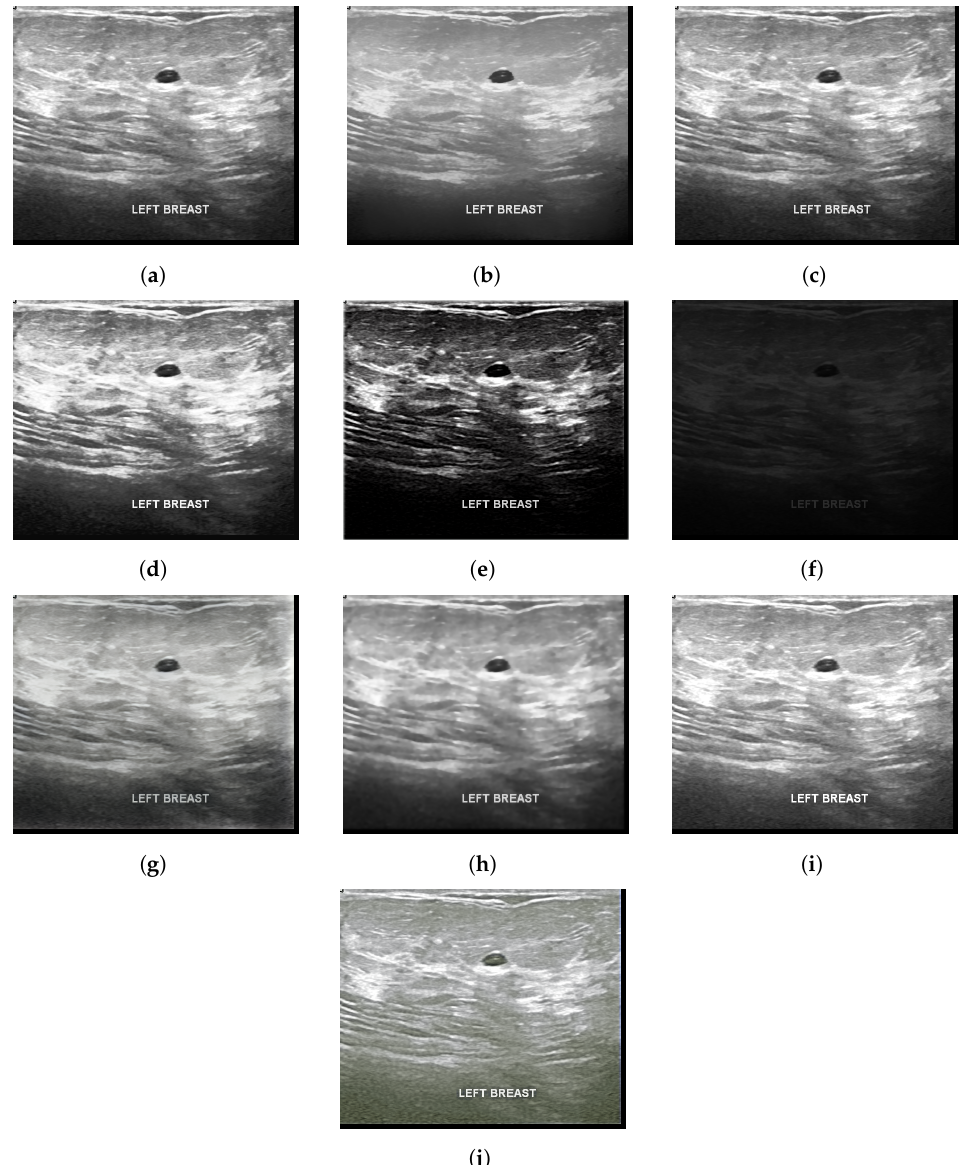
Figure 5. Benign highlighted mammogram images ( a ) Original ( b ) Bilateral ( c ) Gamma correction ( d ) HE ( e ) LDNET ( f ) LIME ( g ) LLFLOW ( h ) TV ( i ) Ying ( j )